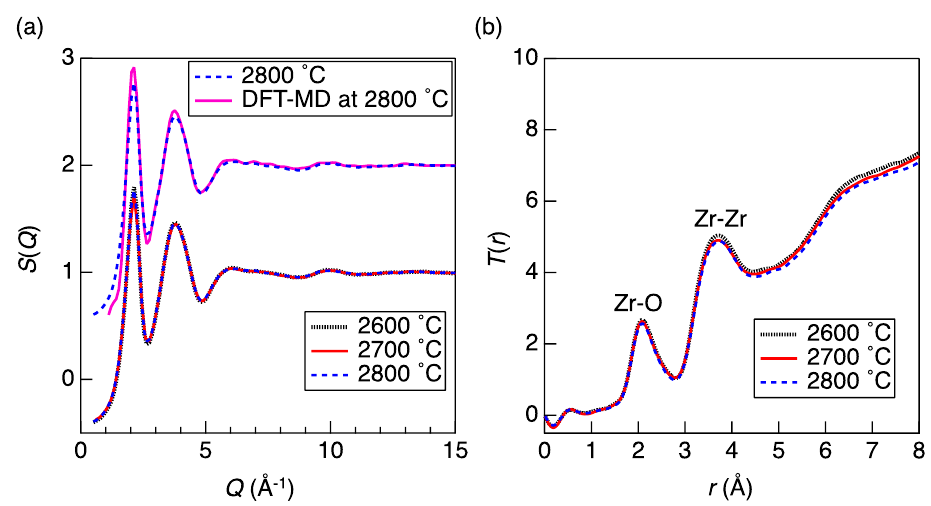
Figure 2. ( a ) Total structure factors S(Q) for l -ZrO 2 at 2600–2800 ◦ C together with S(Q) derived from a density functional theory (DFT)-molecular dynamics (MD) simulation at 2800 ◦ C. Both the experimental and DFT-MD simulation data at 2800 ◦ C are shifted upward by one unit for clarity. ( b ) Total correlation functions T(r) for l -ZrO 2 at 2600–2800 ◦ C [7].